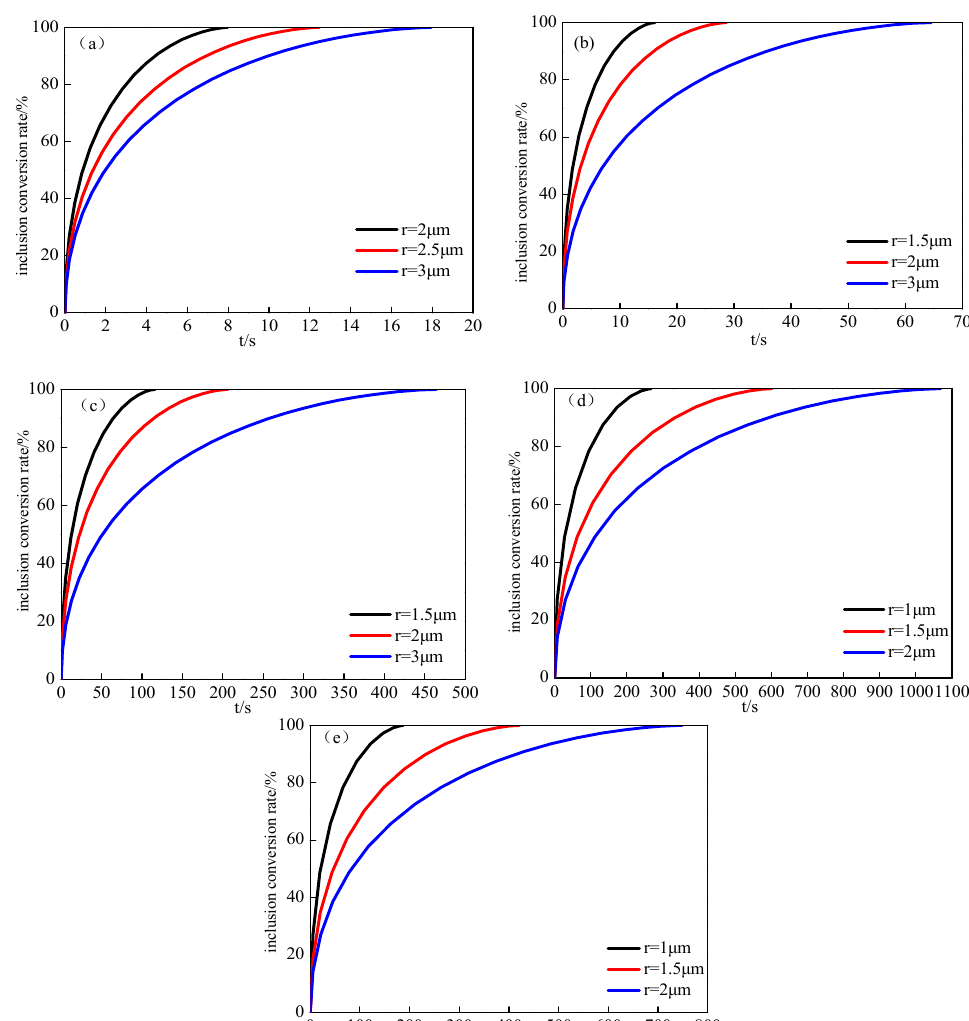
Figure 11. Modification process of inclusions with different particle sizes ( a ) Al 2 O 3 is modified into CA6, ( b ) CA 6 is modified into CA 2 , ( c ) CA 2 is modified into CA, ( d ) CA is modified into C 12 A 7 , ( e ) C 12 A 7 is modified into C 3 A).